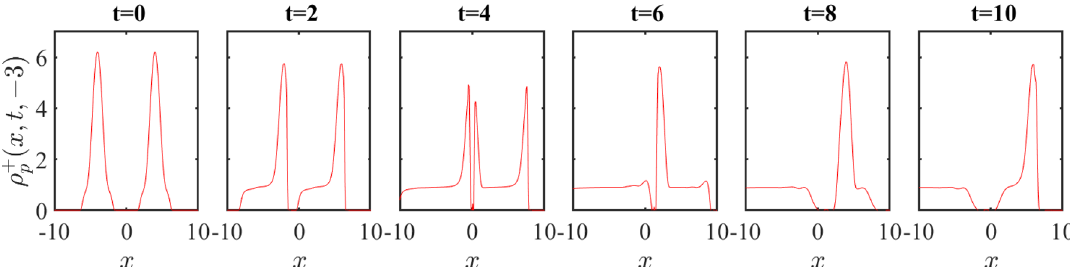
Figure 17 . Spectral density cuts of particle ( + ) for θ = − 3 cutting across the subsidiary peaks. Within the time t = 0 to 10 we observe the decay of the right subsidiary peak and the left subsidiary peak transfer from the left tail to the right tail. We also see that the tails never touch each other (we call this “tail shyness” inspired by the phenomenon of crown shyness that is observed in trees [47]).